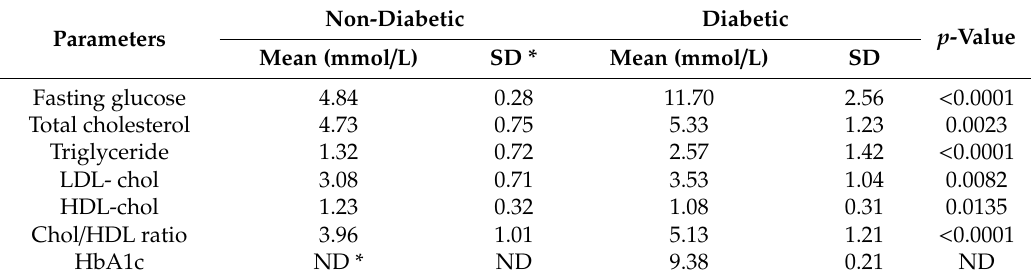
Table 2. Non-diabetic and diabetic male patient’s biomarkers of dyslipidemia.